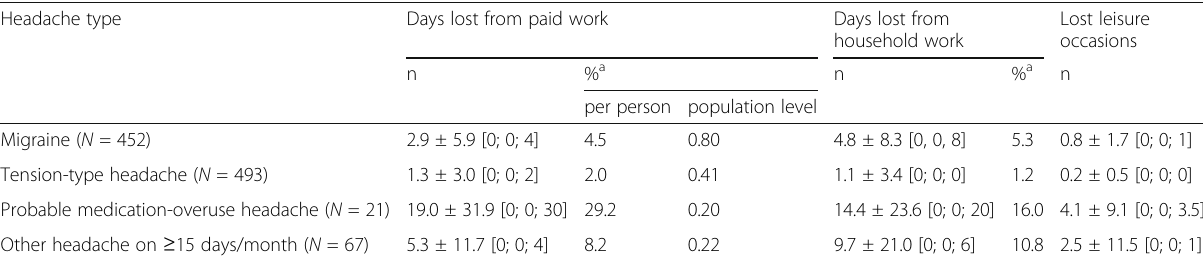
Values of n are means ± SD [quartile 1; median; quartile 3]. a Percentage of total days available for paid work (denominator 65) or household work (denominator